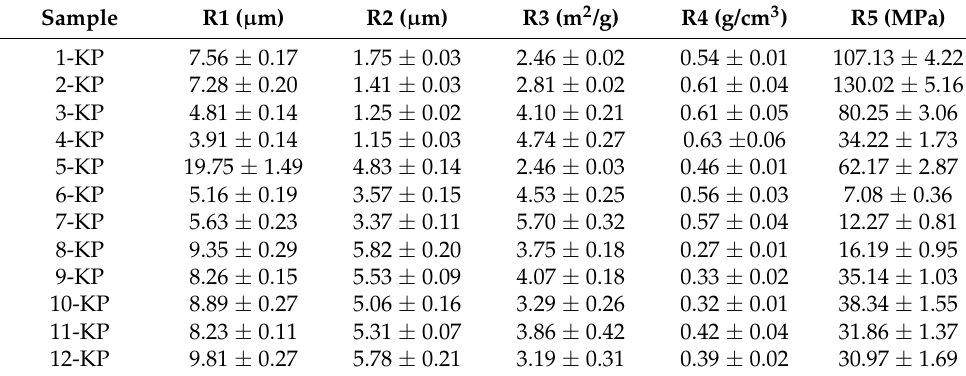
Table 3. Characterization results for polyDCPD composites (R1: average cavity diameter; R2: intercon- necting pore diameter; R3: BET specific surface area; R4: foam density; R5: compression